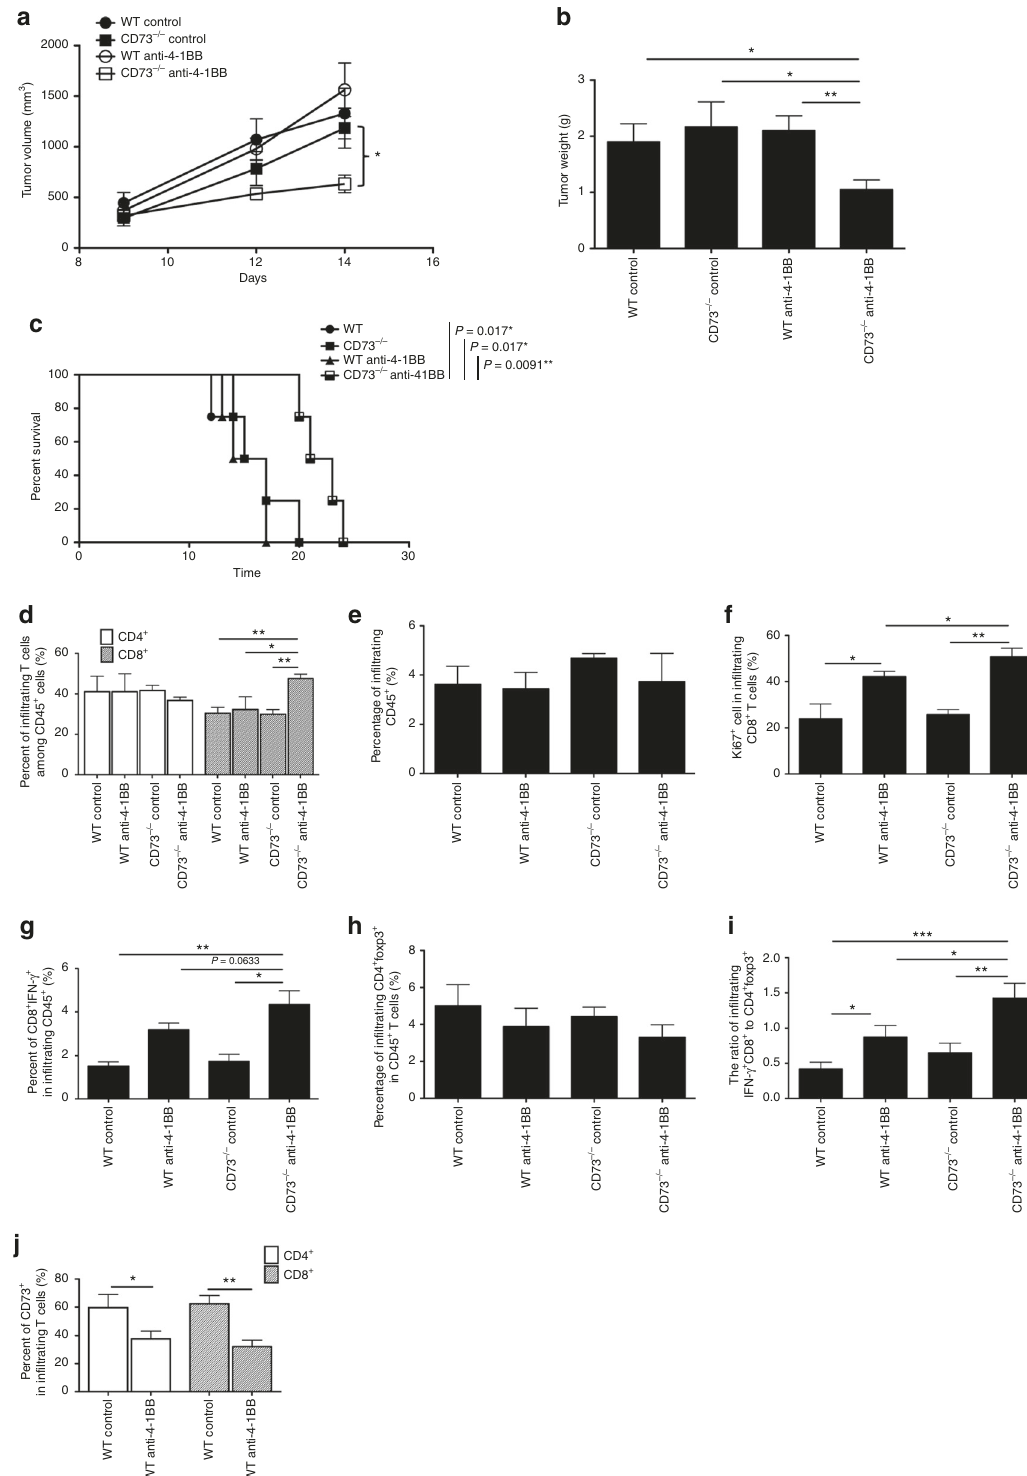
Fig. 4 CD73 de fi ciency on T cells is suf fi cient to improve anti-4-1BB therapy. B16-SIY tumor-bearing Rag1 − / − mice receiving WT or CD73 − / − pan-T cells were treated with control IgG or anti-4-1BB. a Tumor size was measured every 2 – 3 days. b Tumor weight was measured 14 days after tumor challenge.